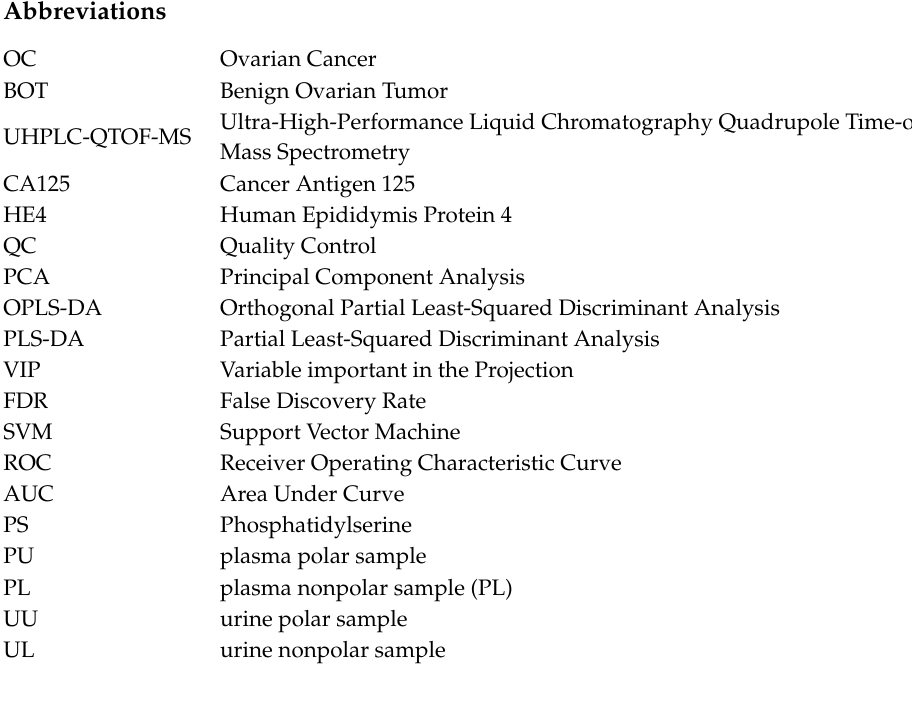
Figure S1: Technique pipeline to identifying potentially biomarkers panels in three comparison groups, Figure S2: Score plots of PCA from the two batch of urine samples, Figure S3: Score plots of PCA from the two batch of plasma samples, Figure S4: The OPLS-DA score plot and the permutation test results of urine samples, Figure S5: The OPLS-DA score plot and the permutation test results of plasma samples, Figure S6: Compound category of di ff erential putative metabolites, Figure S7: Prediction plot of the hybrid model for distinguishing benign and malignant (borderline + malignant) ovarian tumors, Table S1. Other clinical characteristics of the samples in each set. Table S2: Statistical analysis of di ff erential urine putative metabolites from three group of comparison, Table S3: Statistical analysis of di ff erential plasma putative metabolites from three group of